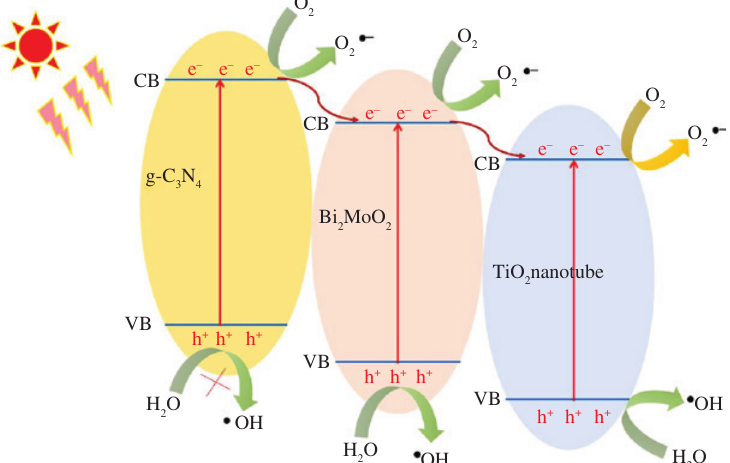
Figure 14: Probable mechanism of the separation of photogenerated e − –h + pairs during the decolorization of dye caused by a ternary com- posite photocatalyst (g-C